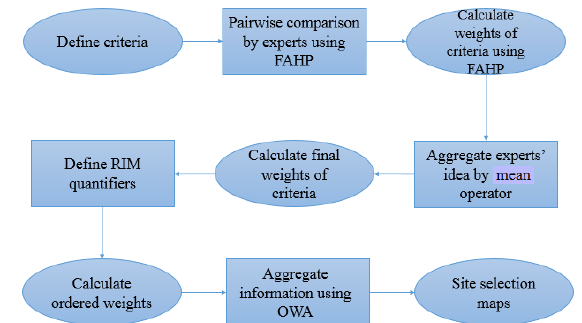
Figure1- Steps of site selection using Q-OWA Fuzzy AHP